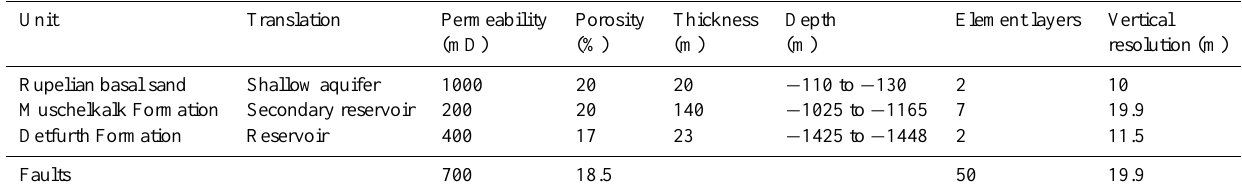
Table 2. Vertical grid discretisation, depth and hydraulic parameters for the active geological units. Unit Rupelian basal